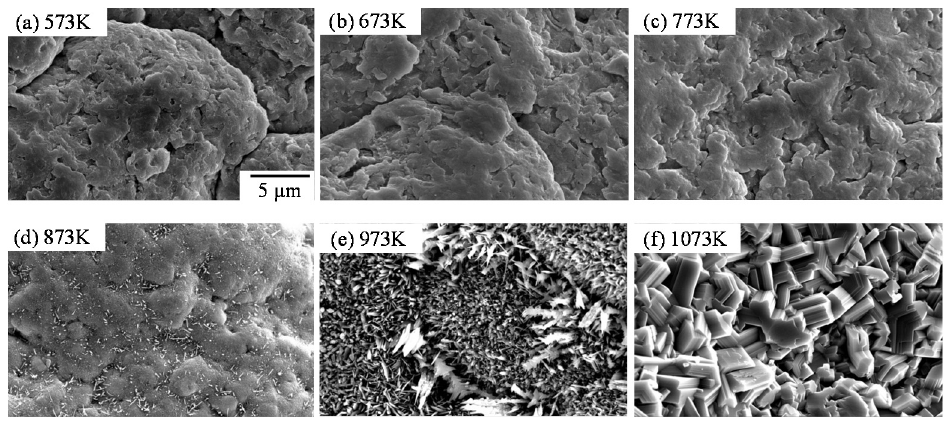
Figure 26. SEM images of surfaces of M10- x K-50h